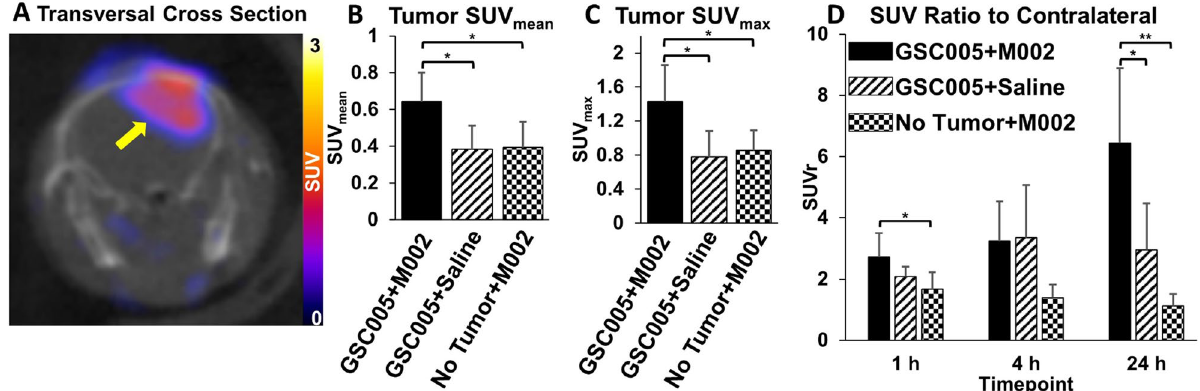
Figure 3. PET imaging shows increased accumulation of [ 89 Zr]-malDFO-169 cDb in tumor bearing mice after M002 immunotherapy. ( a ) Representative PET/CT transversal cross section of a mouse in the GSC005 + M002 group showing retention of activity in the tumor (yellow arrow) at 24 h after tail vein injection of [ 89 Zr]- malDFO-169 cDb. The image was generated using VivoQuant software (version 3.5patch 2, Invicro, LLC). ( b ) ROI analysis of the tumor region at 24 h shows significantly higher levels of activity (SUV mean ) in mice with GSC005 tumors and M002 oHSV than with either alone. ( c ) Similarly, the SUV max at 24 h was highest in the GSC005 + M002 group relative to the other groups. ( d ) The SUVratio (SUVr) between tumor-bearing brain and normal brain increased over time in the GSC005 + M002 group. Data in graphs are presented as group mean values and standard deviation. *p < 0.05, **p < 0.01 Graphs were generated using GraphPad Prism software (Version 6.1).